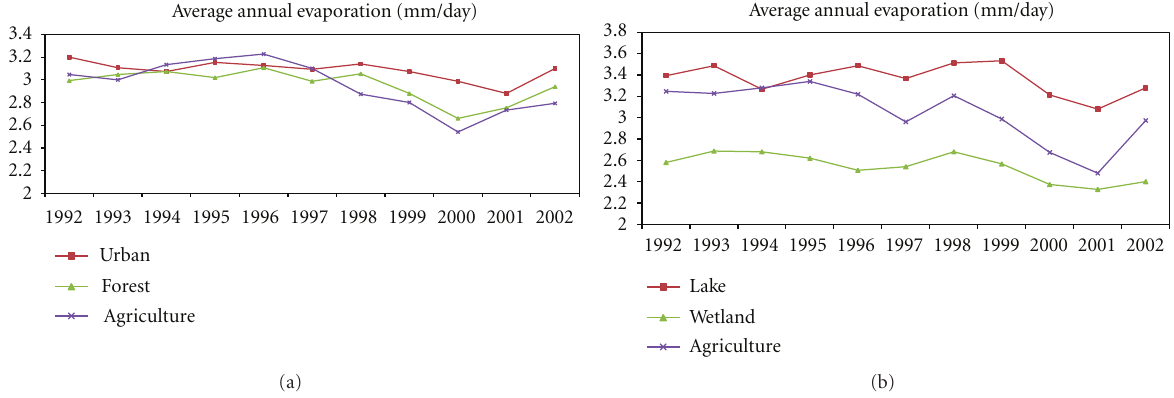
Figure 7: (a) The average annual actual evaporation in Northeast Florida. (b) The average annual actual evaporation in South Florida.